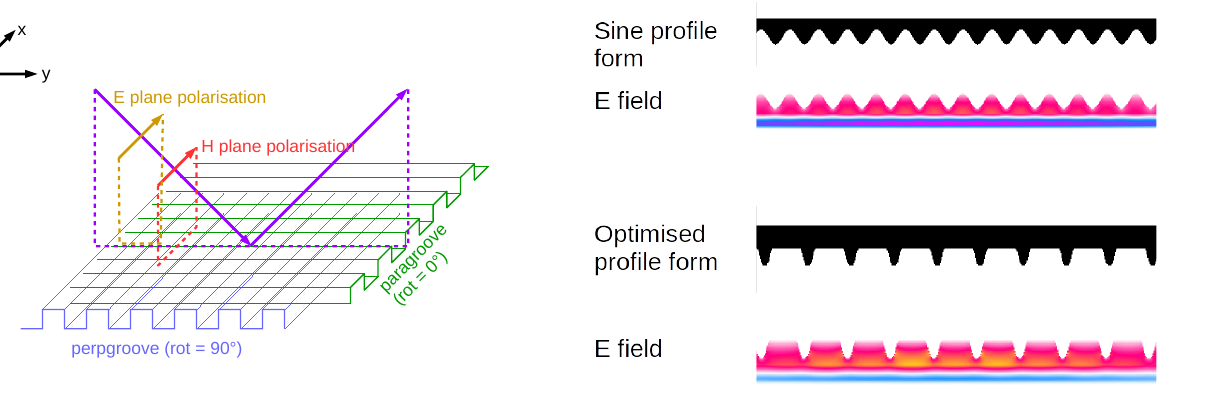
Figure 3. Electric fields in the polariser grooves for the sinu- soidal and the optimised “E8_4”